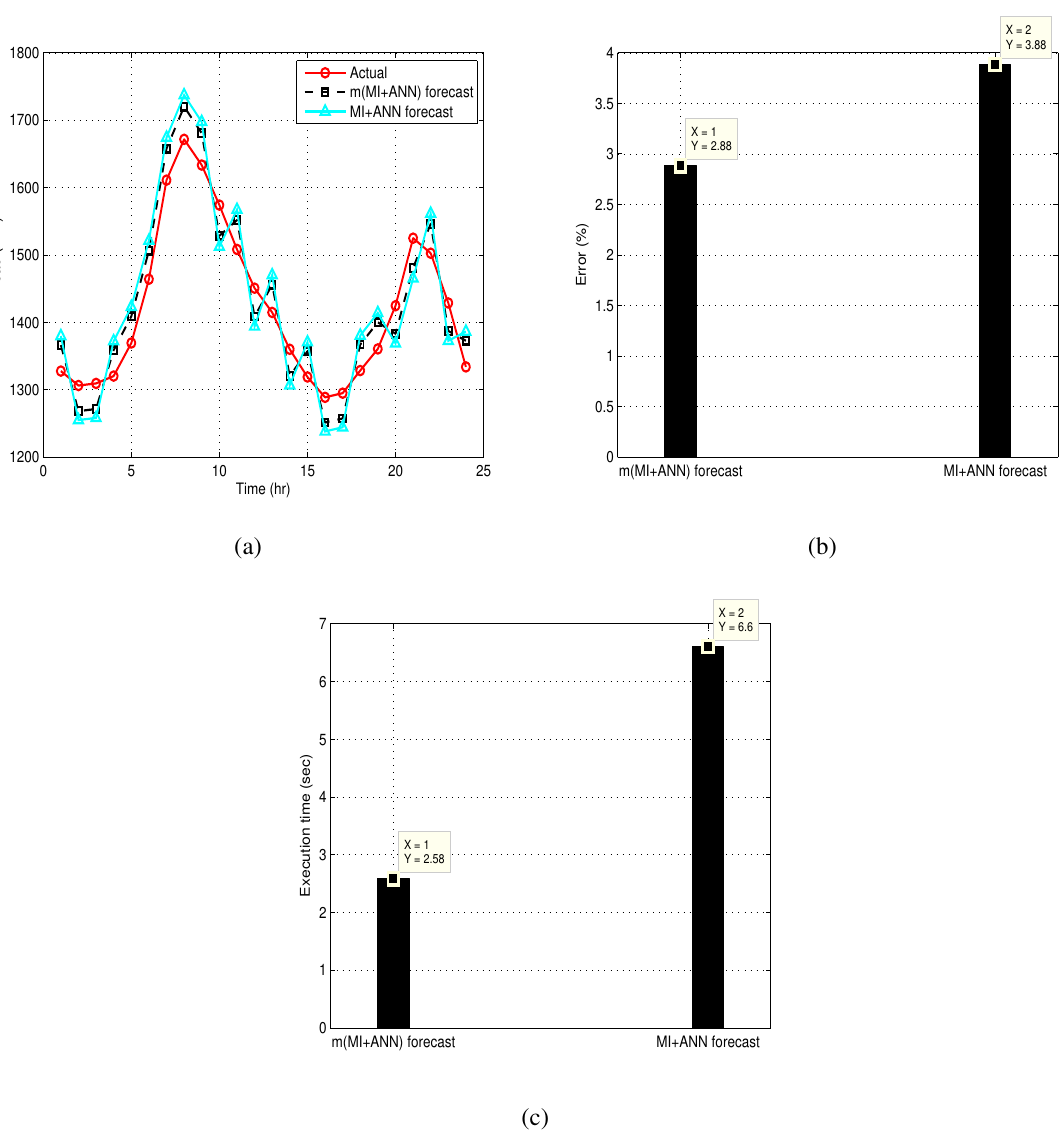
Figure 7. EKPC (27 January 2015): m(MI + ANN) forecast vs. MI + ANN forecast. ( a ) Actual vs. forecast; ( b ) Error performance; ( c ) Convergence rate